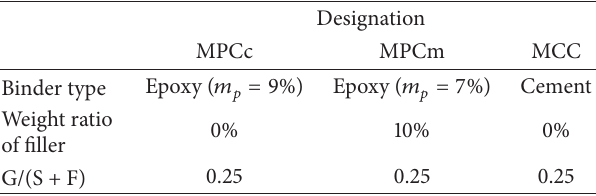
Table 4: Designation and composition of the three selected microp- olymers under